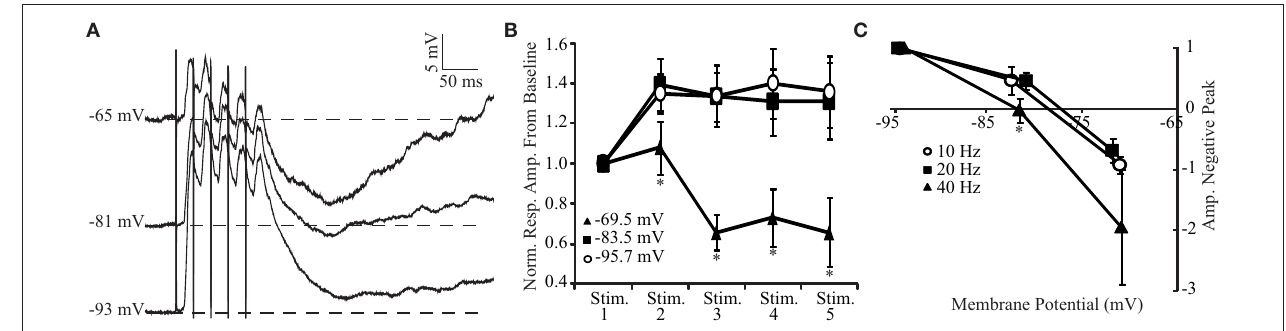
levels. (C) Cumulative plot of the normalized post-train inhibitory peak amplitude versus holding potential. For all frequencies, the peak was more negative at depolarized membrane potentials. However, inhibition was more pronounced at 40 Hz. x -axis: voltage, y -axis: normalized amplitude of the negative peak. For (C) : empty circle, 10 Hz; black square, 20 Hz; black triangle, 40 Hz. x -axis: holding membrane potential; y -axis: amplitude of the negative peak. For (B) and (C) , data are presented as mean ± SEM and asterisks indicate significant differences.